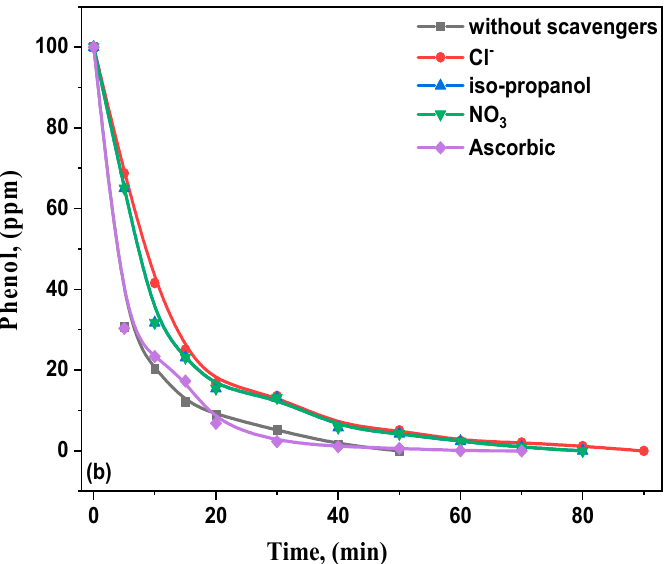
Figure 10. ( a , b ) Trapping agent data for photodegradation using Eu 2 O 3 -doped ZnO of: ( a ) MB; ( b ) phenol.